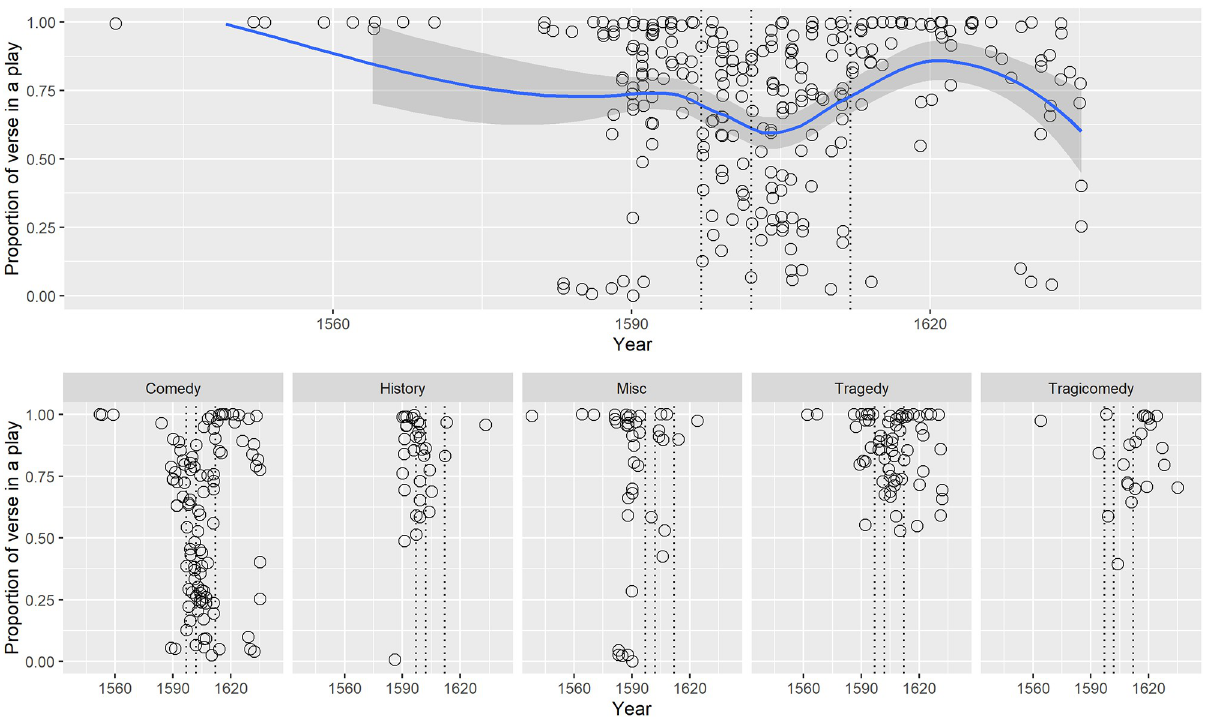
Fig 6. (S1 Fig 7 in S1 File) (a) Proportion of verse in a play by date (upper)and (b) proportion of verse in play by date, in five genre groups (lower).